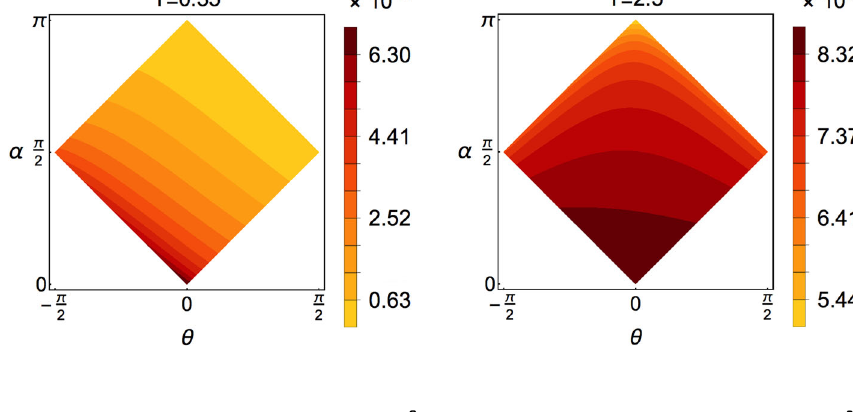
Fig. 8 Entropy per unit area for low (left) and high (right) temperatures with n 1 = 0. In these plots L =